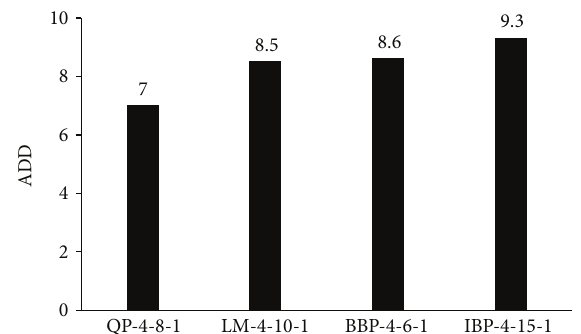
Figure 3: The AAD of QP-4-8-1, BBP-4-6-1, IBP-4-15-1, and LM-4- 10-1 topologies in testing data set.